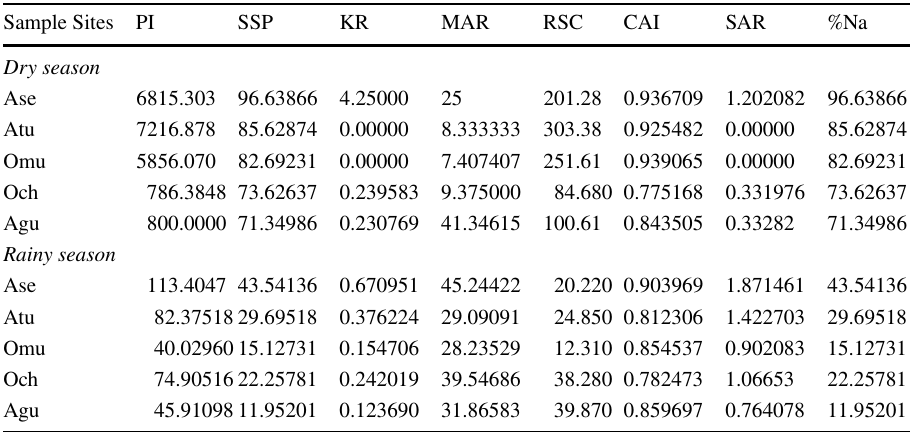
and percent sodium